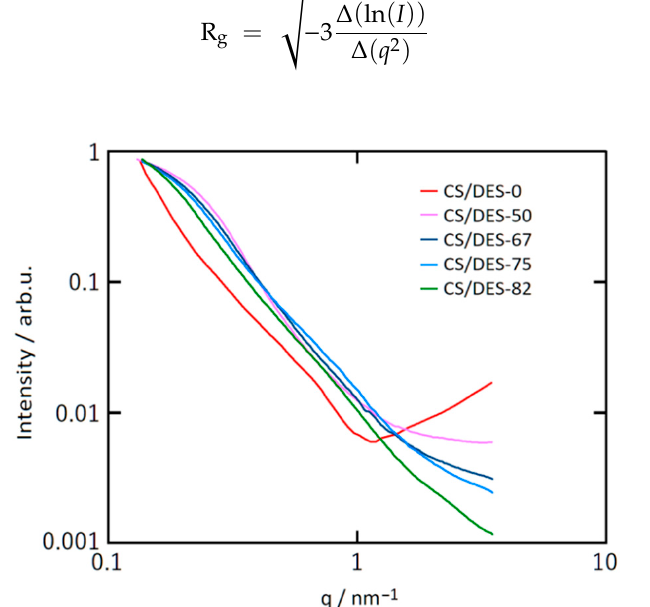
Figure 5. SAXS patterns of CS-LA film (CS/DES-0) and films with different NADES contents (50, 67, 75 and 82 wt%).